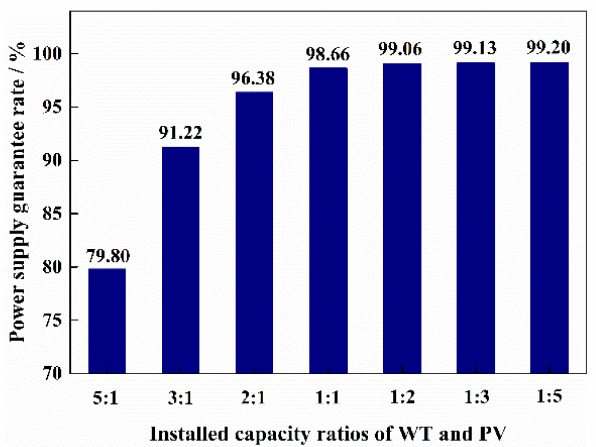
Figure 13. Power supply guarantee rate with different installed capacity ratios of WT and PV in